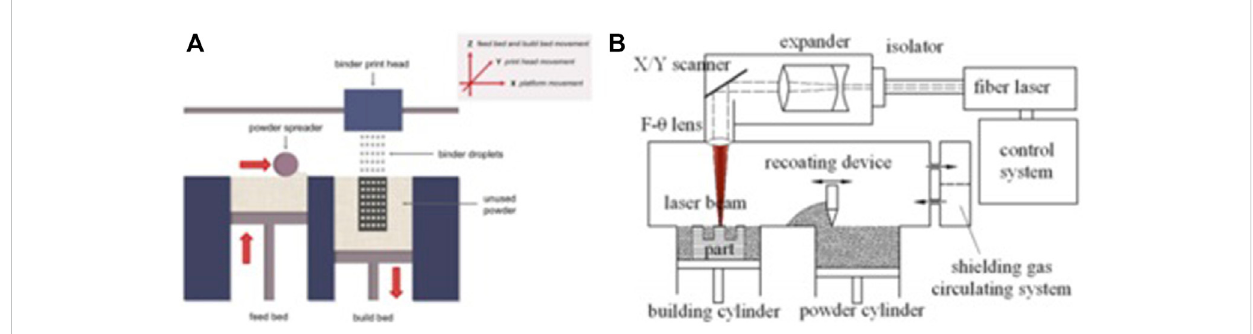
Schematicsofthepowderbedmethod (A) andtheSLMmethod (B) ,reproducedwiththepermission(Brunelloetal.,2016) Copyright©2016Elsevier Inc. and the permission (Liu et al., 2015b) Copyright © 2015 Published by Elsevier Ltd. ,